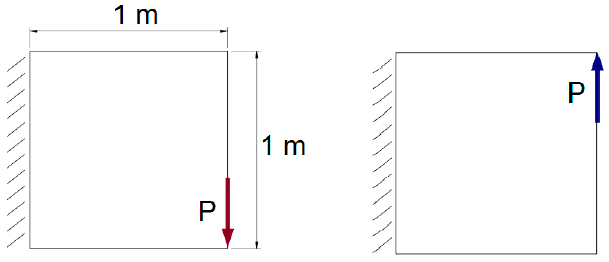
Figure 35. The initial structure with applied loads—the two loads scheme and support. The initial regular mesh consisted of 1156